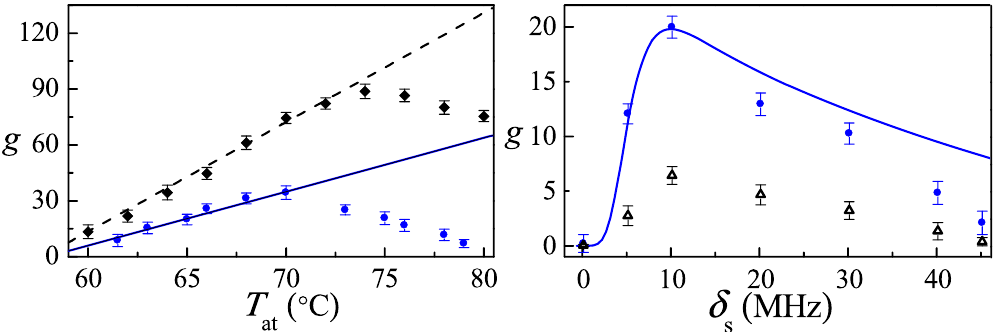
Figure 4. Gain at δ ps = 0 vs ( a ) T at for different P s : 10 mW (blue circles), 20 mW (black squares); and ( b ) δ s with phase-locked (blue) and independent (black) signal and probe fields. ( a ) The atomic density is ∼ × − 4 10 10 cm 11 3 with ToP rate 240~600 Hz, δ those in Fig. 2(b,d). The solid line represents the